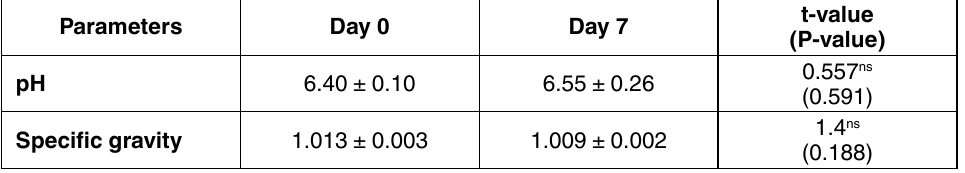
table 5. Observations on urine pH and specific gravity (Mean ± SE) in tom cats (n=12)